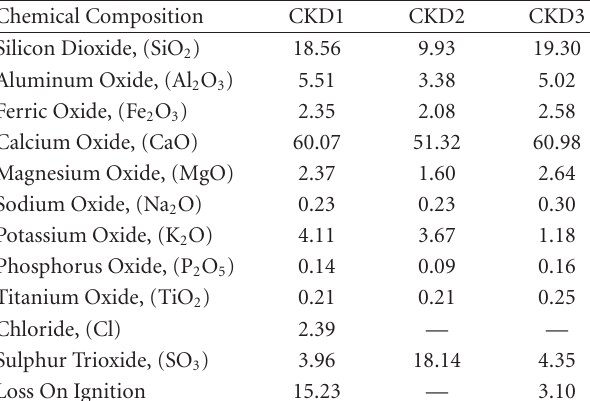
Table 2: Chemical compositions of the di ff erent